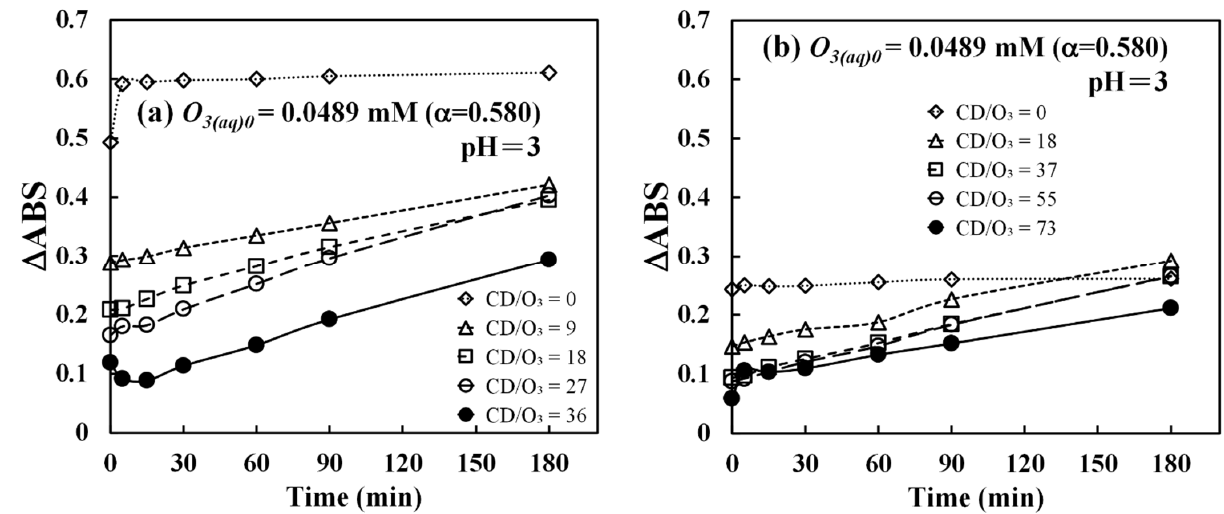
Figure 4. Data of ∆ ABS as a function of time in ozone release experiments under a series of CD/O 3 molar ratios at two different ozone loading rates at pH 3: ( a ) α = 0.580; ( b ) α = 0.504.